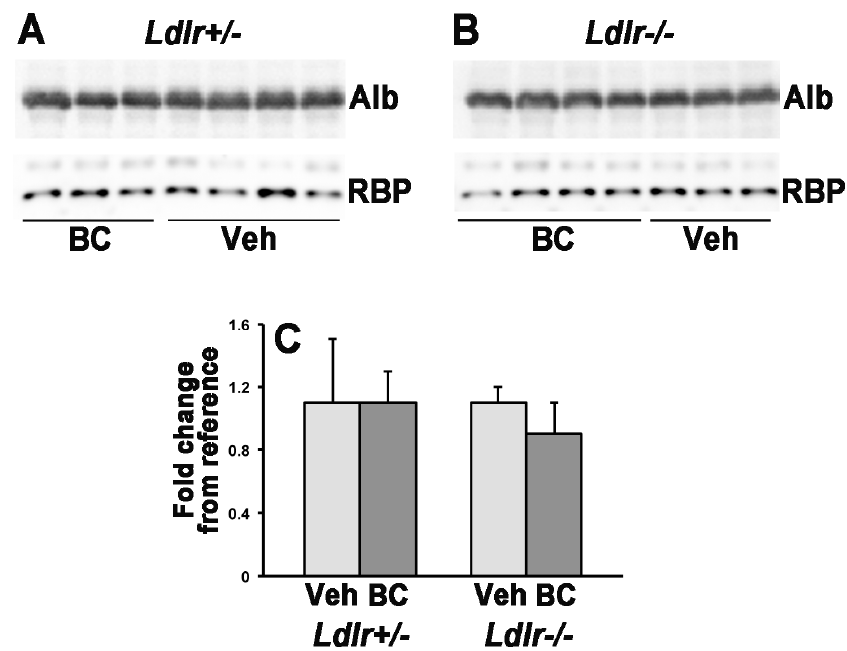
Figure 2. Representative RBP Western blots for Ldlr +/ − ( A ) and Ldlr − / − ( B ) serum samples. Procedures as indicated in the Materials and Methods section. RBP, 21 kDa; Albumin (Alb), 65 kDa; ( C ) Quantification of the Western blot membranes. Results (expressed as mean ± SD) are shown as a fold change from the reference vehicle (Veh) group within each respective genotype. BC, β ‐ carotene. β ‐ carotene concentrations were next determined in lipoprotein fractions (VLDL + chylomicrons; LDL + IDL; and HDL) isolated from sera of Ldlr +/ − and Ldlr − / − dams. Enrichment of each fraction with specific types of lipoproteins was confirmed by measuring the cholesterol and triglyceride content of each isolated fraction. As previously reported [12], cholesterol levels were elevated in whole serum, as well as in VLDL + chylomicrons and LDL + IDL fractions of Ldlr − / − dams compared to the heterozygous females (Table 1).